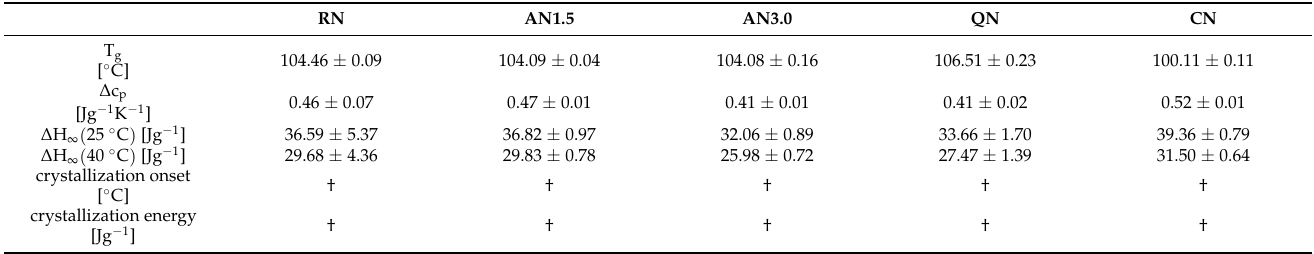
Table A5. Calorimetric data of the 2gl_0.4PS_Tre [ ◦ C]. n = 2, values represent the mean value and the corresponding standard